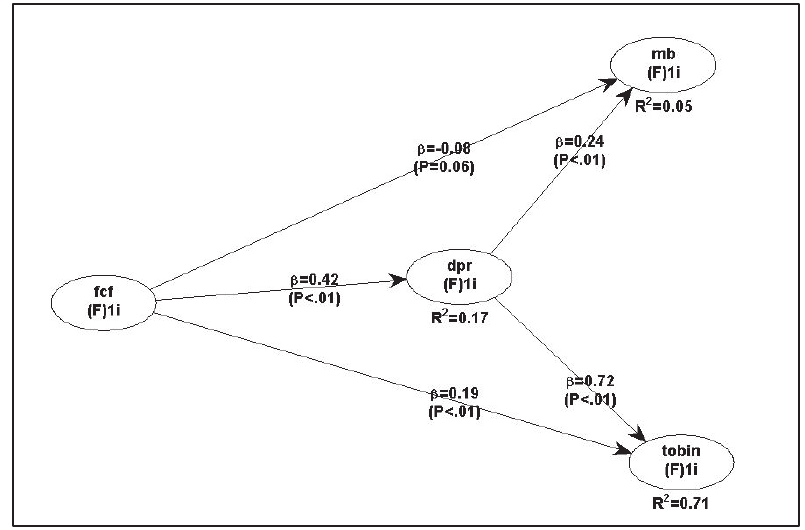
Fig. 2. Research Results Path Chart